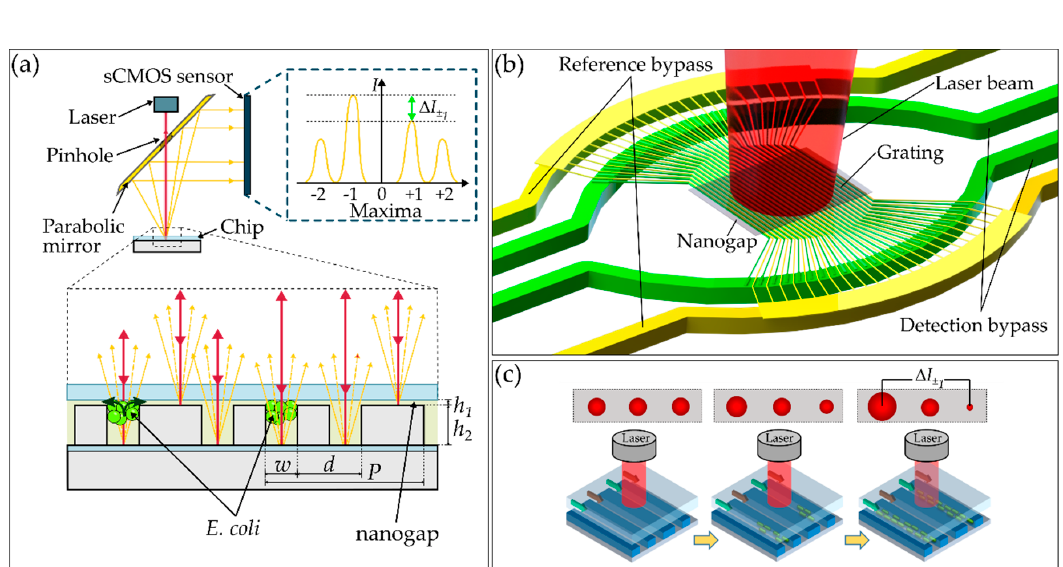
Figure 1. ( a ) Schematic drawing of the measuring principle with a cross-section of the chip and captured bacteria in the detection channels with a height of h 2 = 4 µm, a width of w = 3 µm, a displacement of d = 6 µm and a period of P = 15 µm. Bacteria are captured and cultivated at the 590 nm ( h 1 ) gap. Green arrows in the cross-sectional view indicate the fluid flow. ( b ) Schematic drawing of the microfluidic channels on the chip (yellow and green) and the collimated laser beam (red) directed perpendicular onto the grating. ( c ) Schematic illustration of the change in the difference of the intensities of the maxima ( Δ I ± 1 ) over time as growing bacteria are captured in the detection channels by a pressure loss over the nanogap.